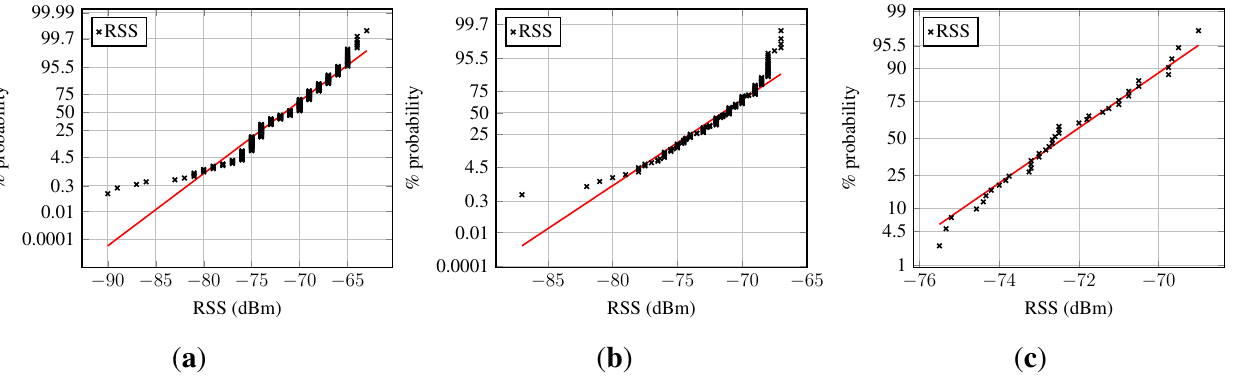
Figure 3. Received signal strength normal probability plot at a fixed location: ( a ) Norm probability plot of RSS; ( b ) norm probability plot of RSS averaged over one second; ( c ) norm probability plot of RSS averaged over five seconds. The linear graph in the normal probability figures connects the first and the third quartile of the data and is then extrapolated towards the